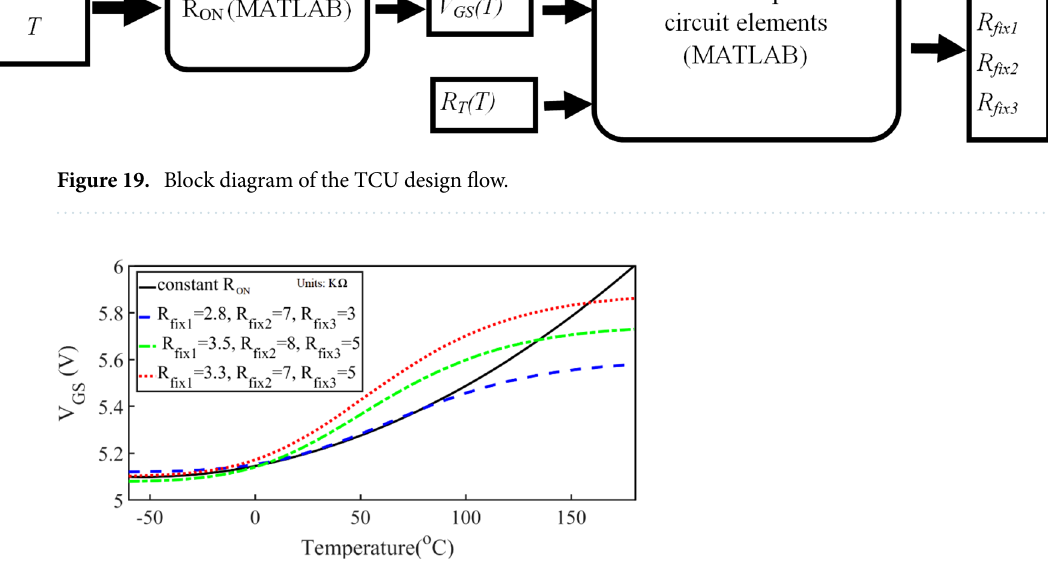
Figure 20. V GS versus temperature for different values of R fix1 , R fix2 , and R fix3 and the constant resistance at 25